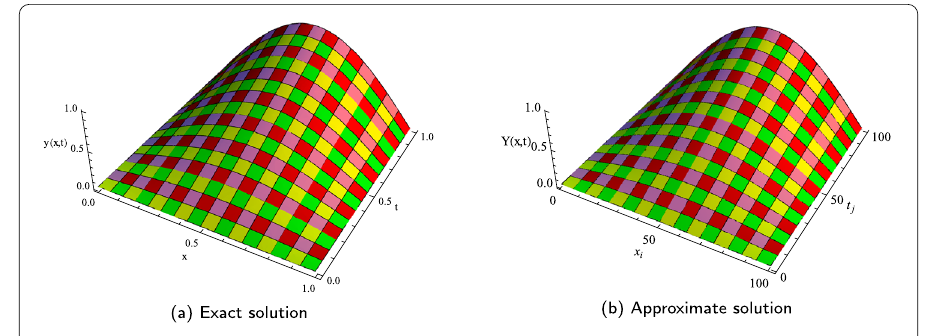
Figure 3 Exact and approximate solution for Problem 2 when n = 100, (cid:12) t = 0.01, and γ = 0.5